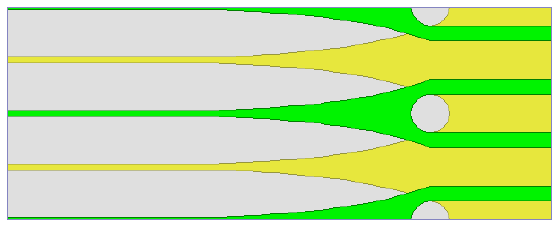
Figure 2: Quadruple Fin Line in Antipodal Configuration.